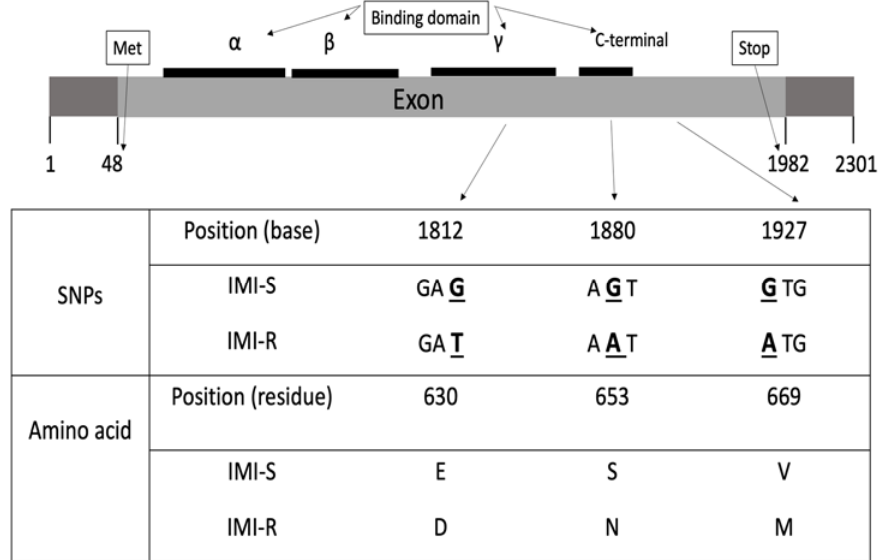
Figure 1. Positions of the three nonsynonymous mutations within the ALS gene and the correspond- ing amino acid listed below the SNPs. The SNPs are underlined and bolded.